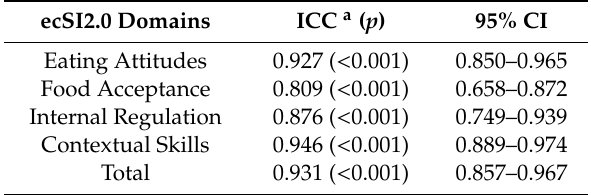
Table 1. Reproducibility of the ecSI2.0 TM BR domains ( n = 32